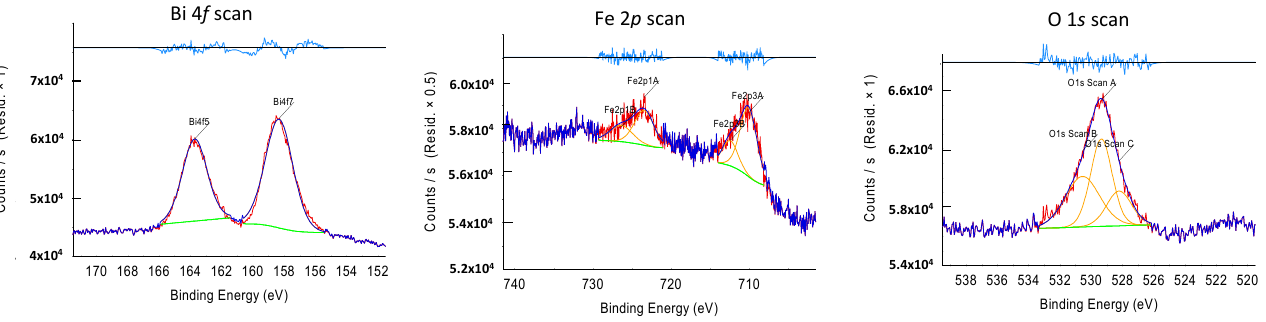
Figure 4. XPS spectra of Fe, Bi, and O for BF.